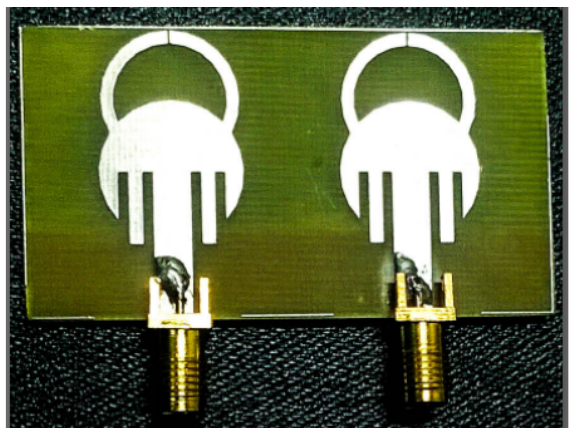
Figure 3 (a): Fabricated Antenna (Front View)